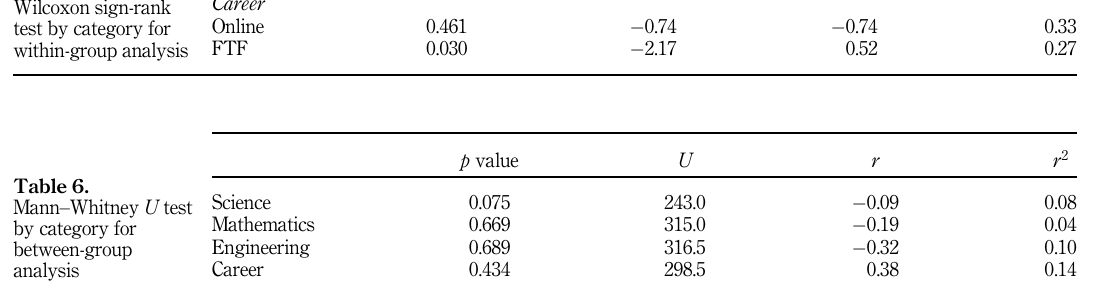
Table 5. Wilcoxon sign-rank test by category for within-group